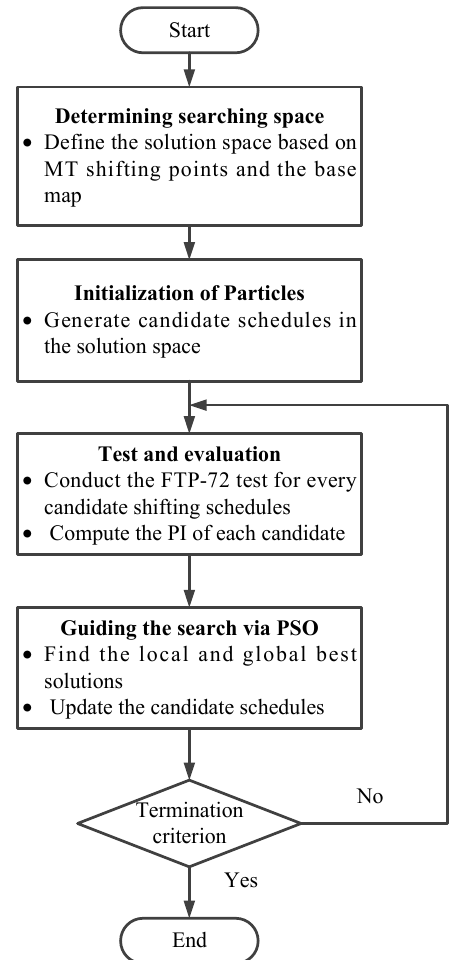
Figure 5. Flowchart of automated optimization process.